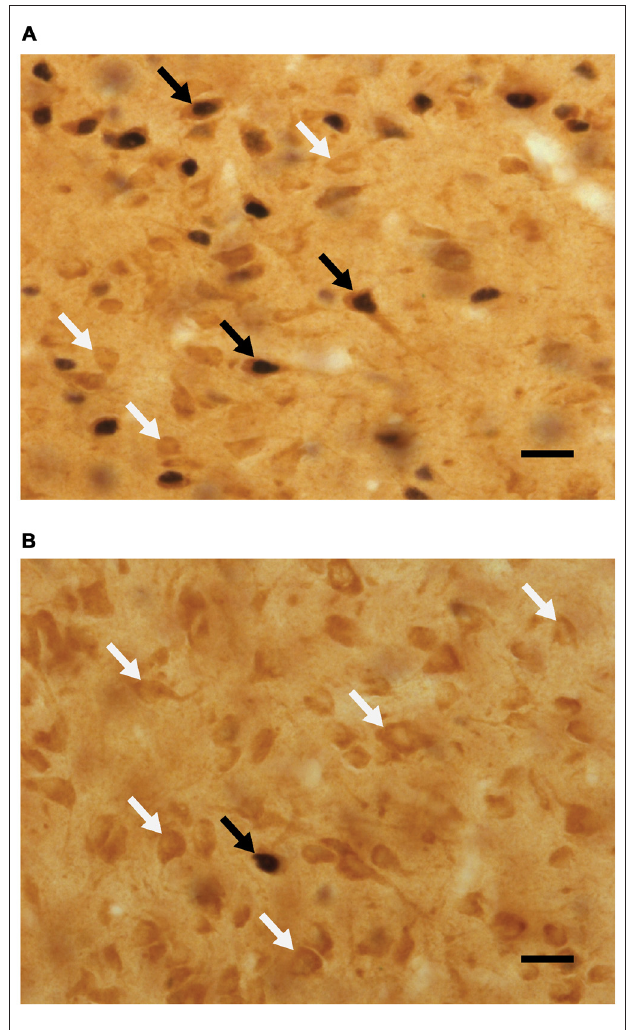
FIGURE 4 | Micrographs portraying representative-colocalized D2- and Fos-immunoreactive cells (black arrows), together with D2- immunoreactive cells (white arrows) in the mPOA. Representative micrographs taken from (A) a sexually experienced male rat that mated on the day of testing and (B) sexually experienced rat that did not mate on the day of testing. Scale bar is 20 µ